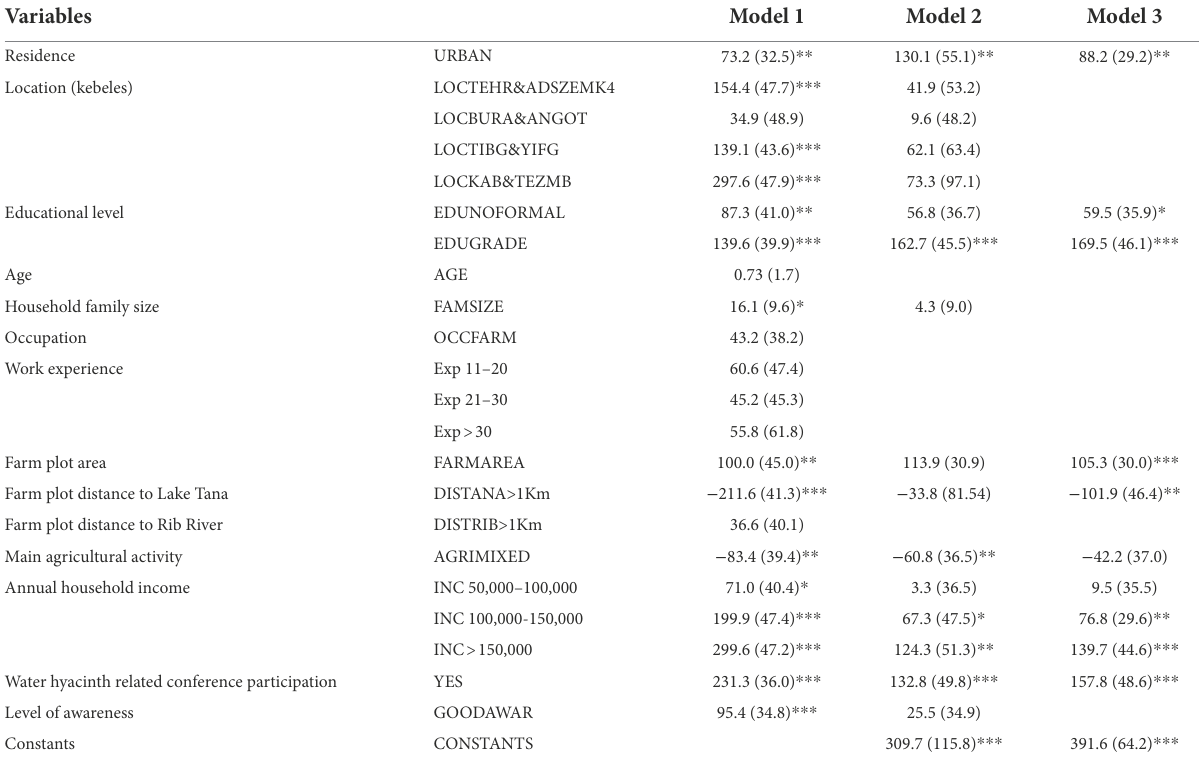
TABLE 1 Bivariable (Model 1) and multivariable (Models 2 and 3) interval regression results of WTP for improving Lake Tana ecosystem services ( n = 183).